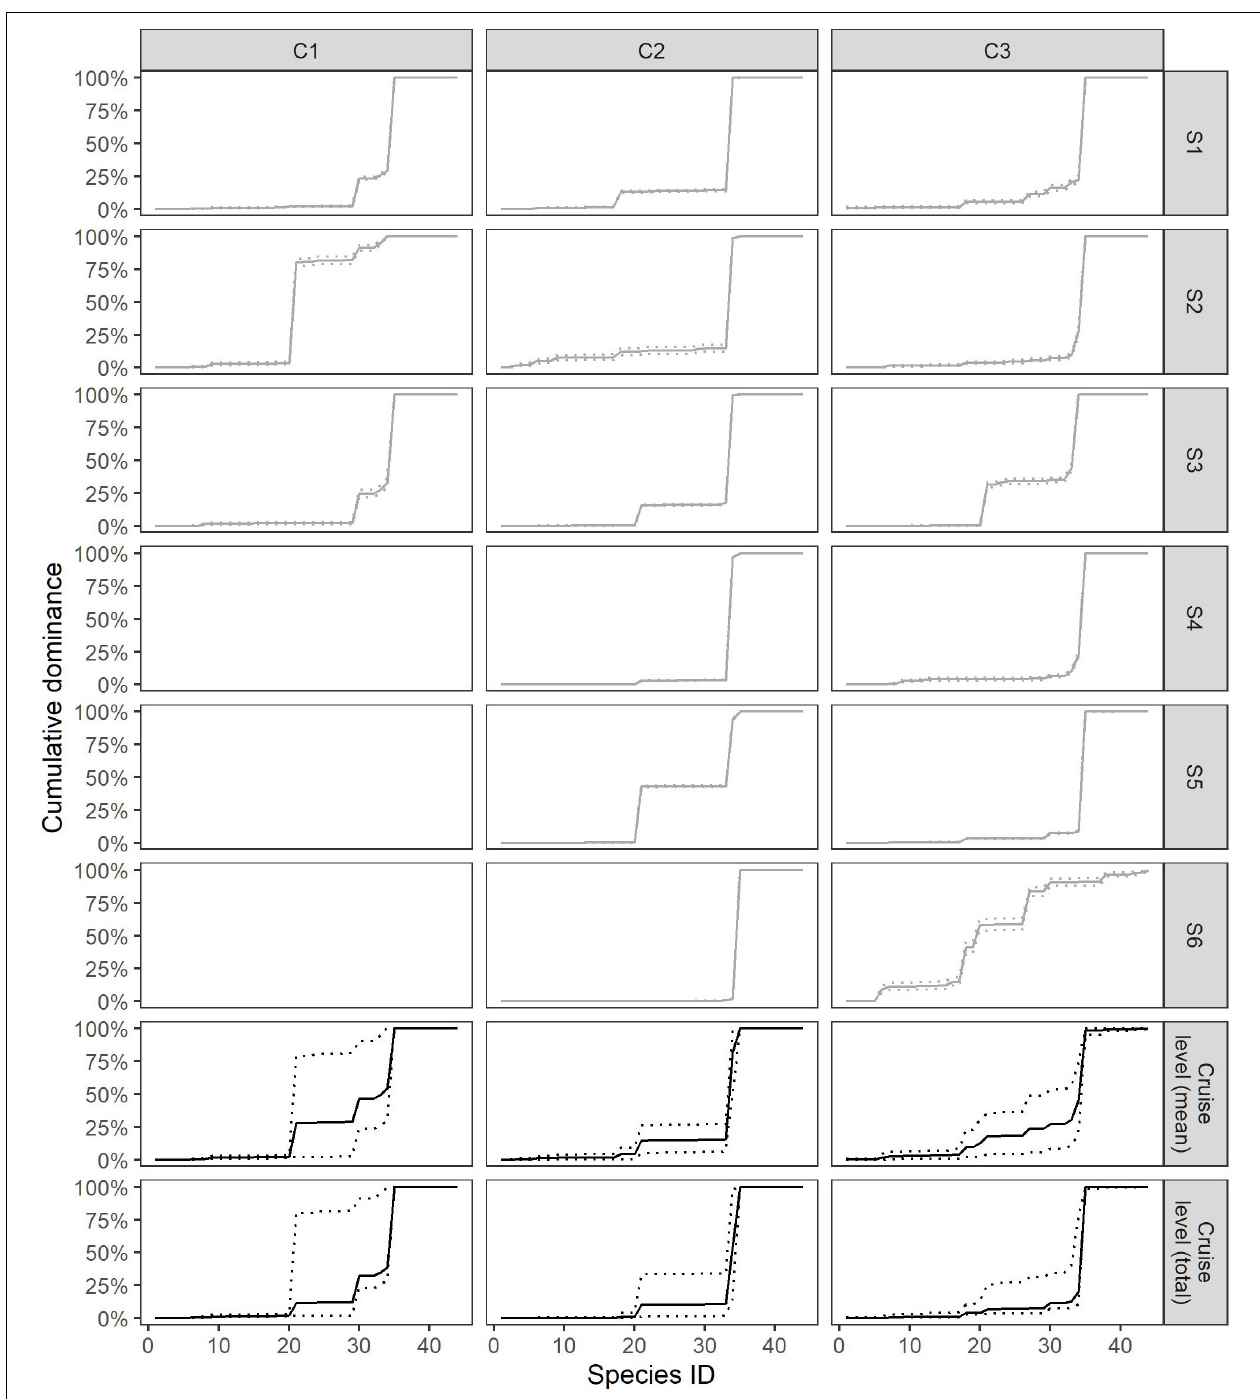
FIGURE 4 | Dominance curves for each station (gray) and mean and total for cruises (black). Dashed lines are 95% confidence intervals. In this case we have made dominance curves where the species ranking remains fixed (see section “Dominance